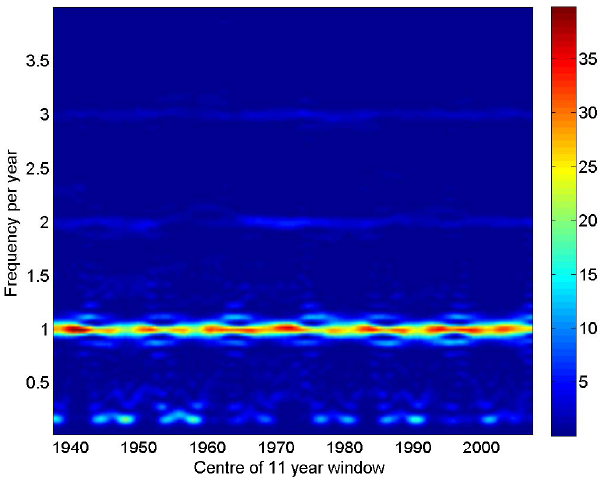
Fig. 4. Time series of the log ratio of semi-annual/annual values seen at Slough/Chilton (dashed line with dark grey error band) and Stanley (solid line with light grey error band) at local noon. The grey error bands represent the error in the mean over the frequency band used to produce each